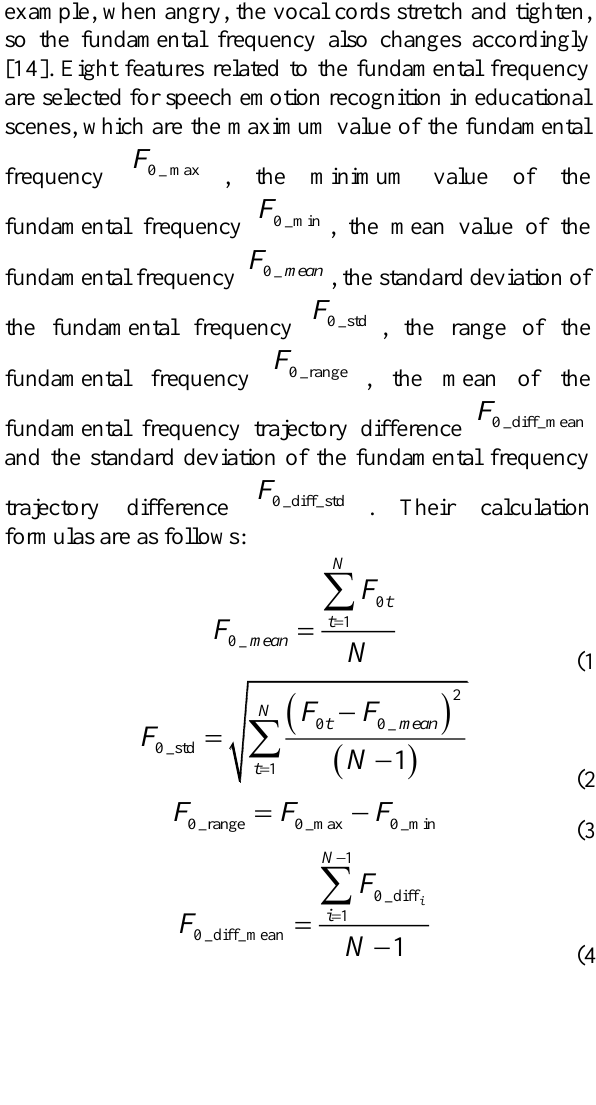
algorithm, classification algorithm, logistic regression